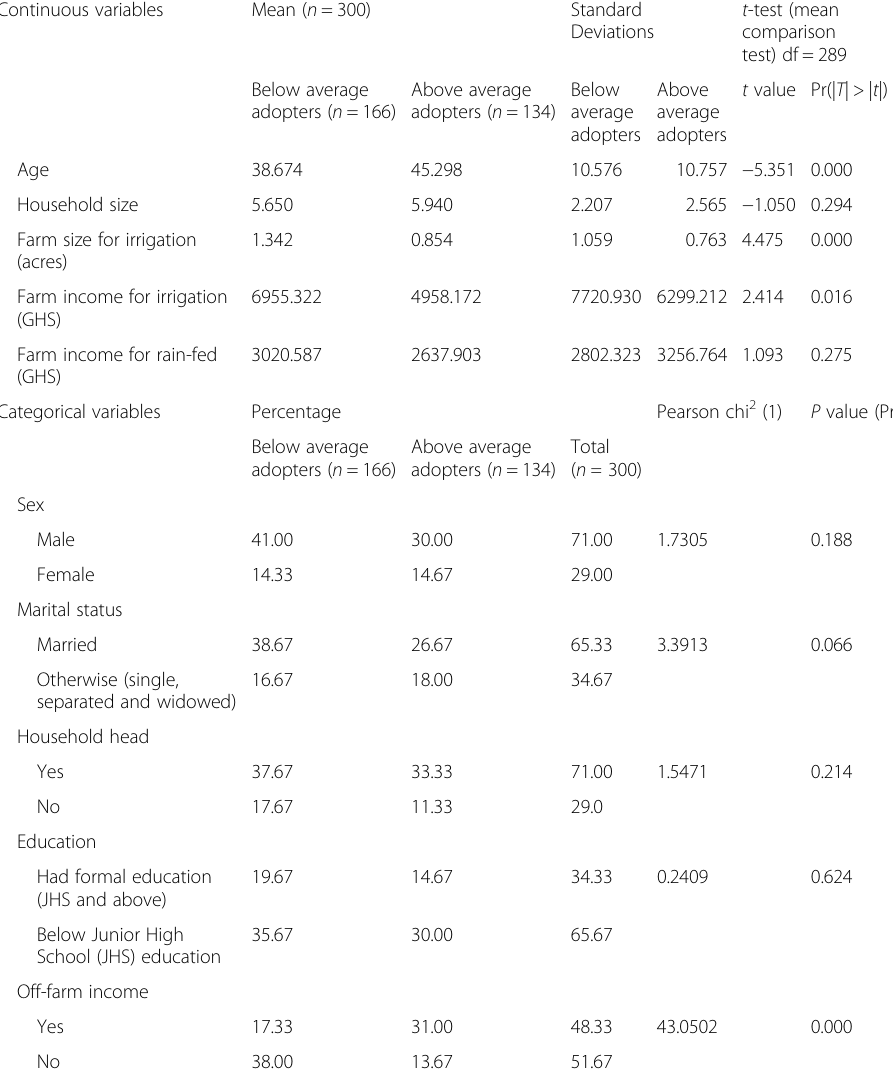
Table 2 Summary of household characteristics Continuous